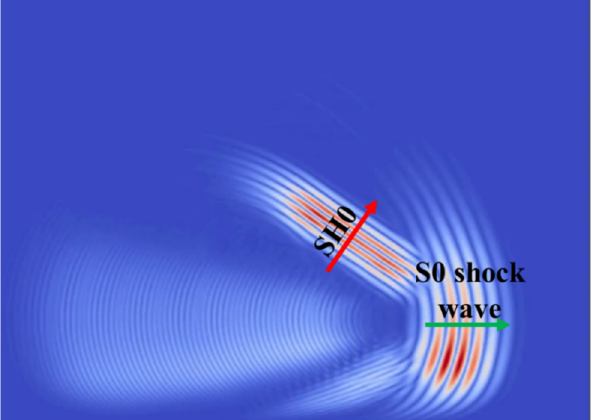
Figure A1. Unwrapped pipe schematic presenting S0 shock wave appearing at 36.6° SH0 plane wave transmission angle.